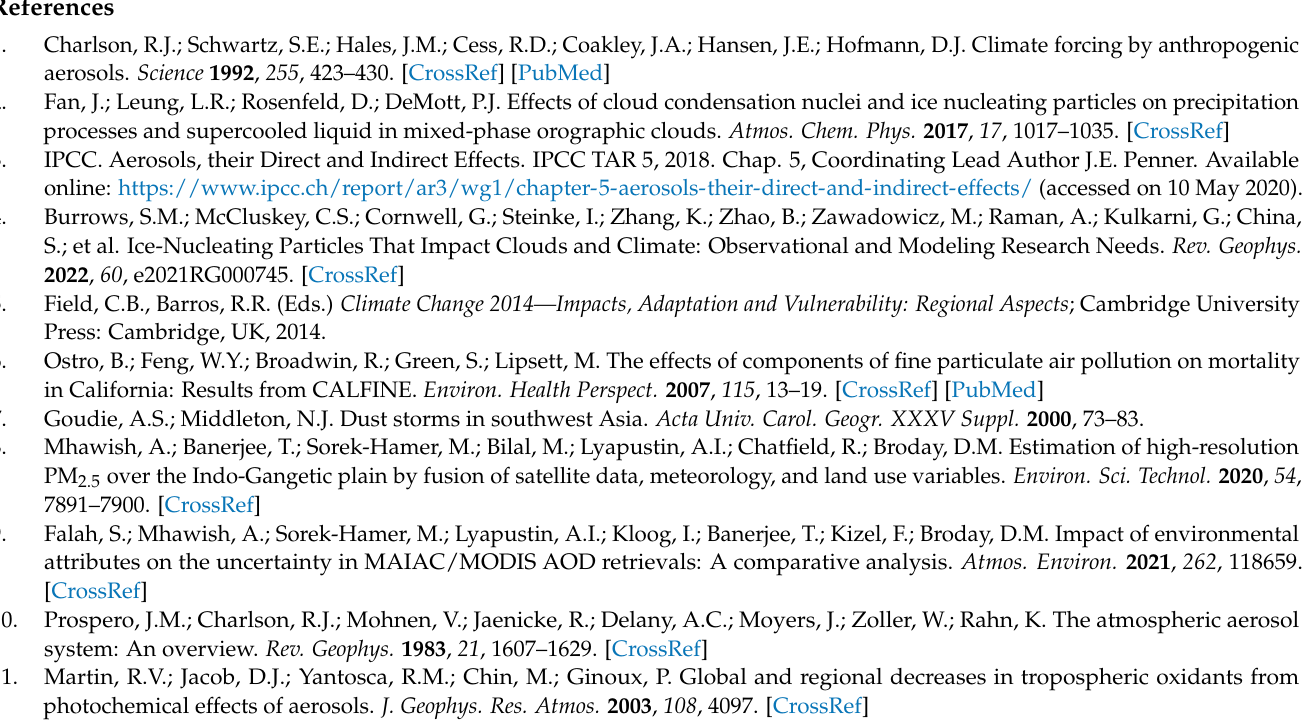
Table S2: Summary of databases used in the